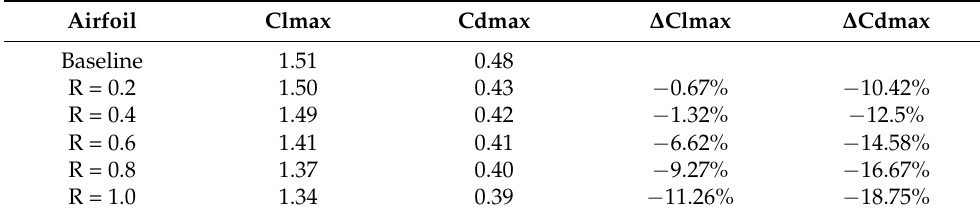
Table 2. Summary of results for different